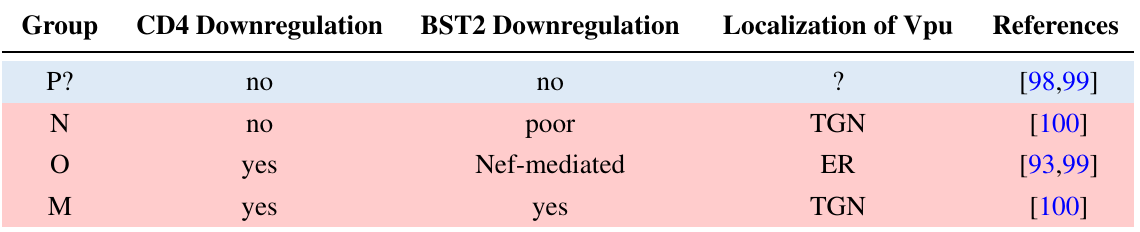
Table 2. Host-adaptation activities of Vpus from each HIV-1 group. The putative P group is extremely rare and is thought to originate from a virus transmission from gorillas